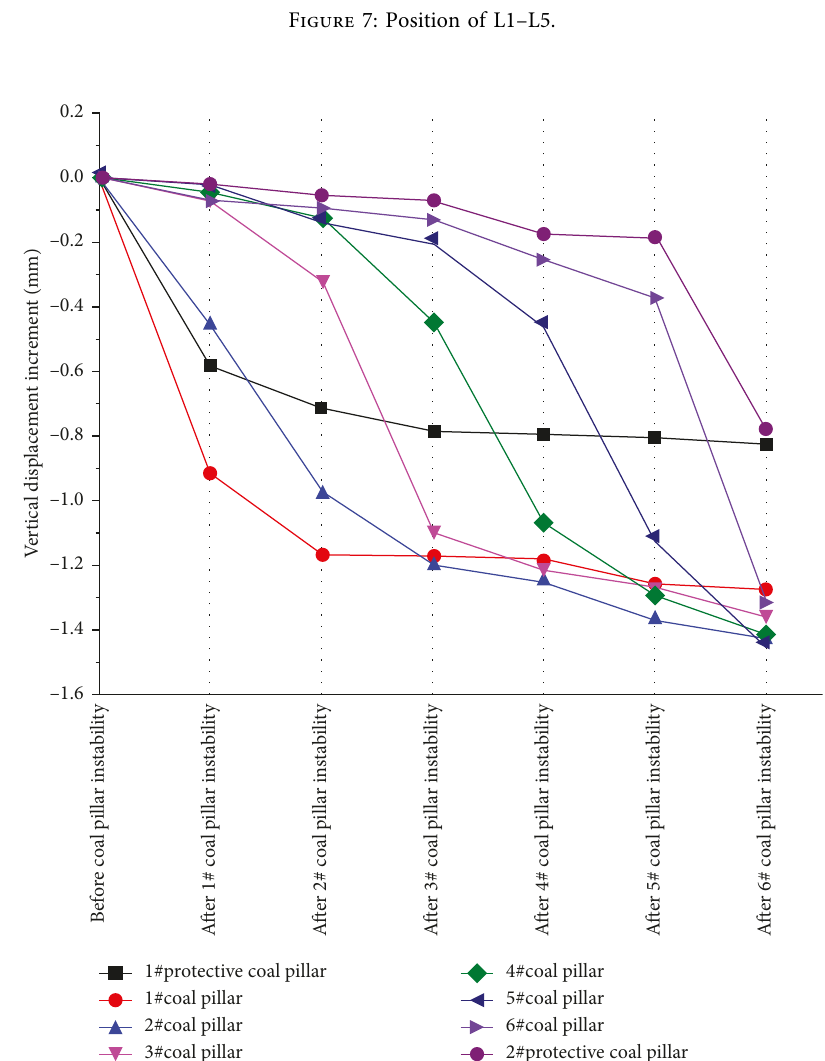
Figure 8: Vertical displacement of measuring point above the coal pillar online L3.